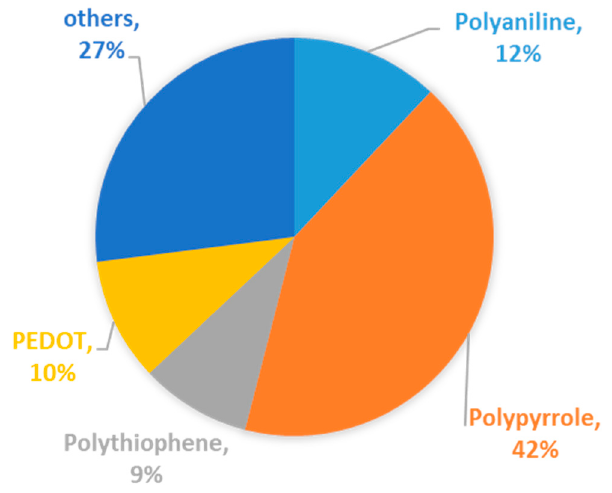
Figure 2. The percentage of various polymers (PPy, PEDOT, PT, PANi, and others) that have been used to coat anode materials so far reported in the literature.